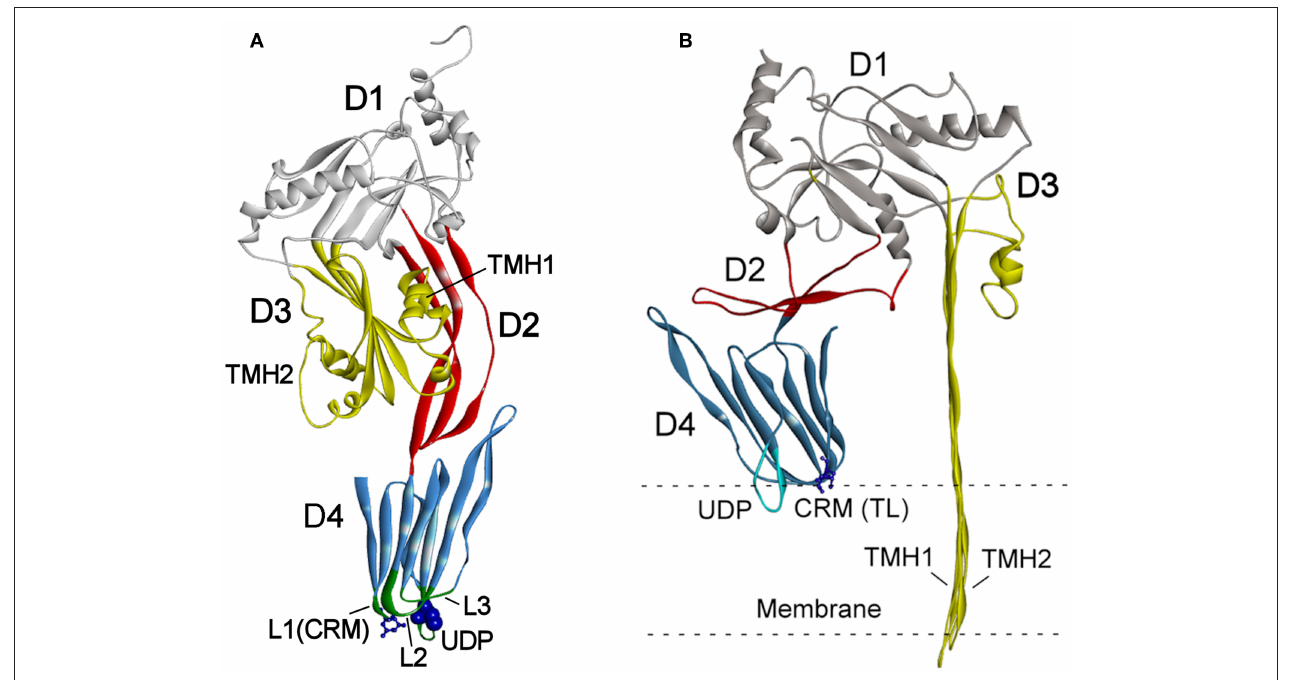
FIGURE 1 | (A) Schematic presentation of the crystal structure of PLY (PDB ID: 4QQA; Park et al., 2016). (B) One subunit of oligomeric PLY inserted into a membrane in the cryoEM structure (PDB ID: 5LY6; van Pee et al., 2017). The features of the structure are marked as follows: domains D1–D4 (highlighted in different colors), loops L1–L3, undecapeptide (UDP) in D4, the two-residue (Thr-Leu pair shown as sticks) cholesterol recognition motive (CRM) in loop L1, and the Cys residue in UDP (shown as blue spheres). The transmembrane hairpins TMH1 and TMH2 of D3 span the membrane in (B)